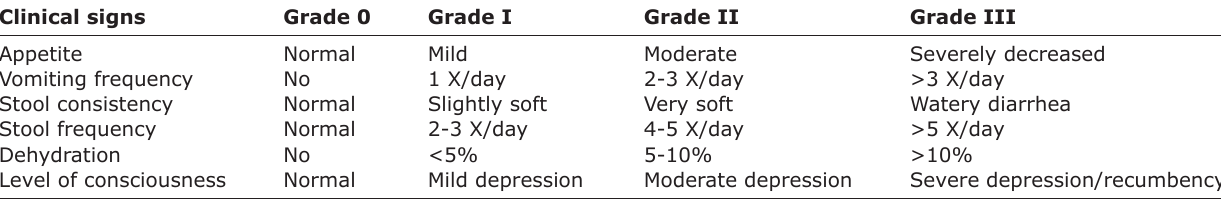
Table-1: Canine HGE index suggested by Unterer et al. [7] with little modifications. Clinical